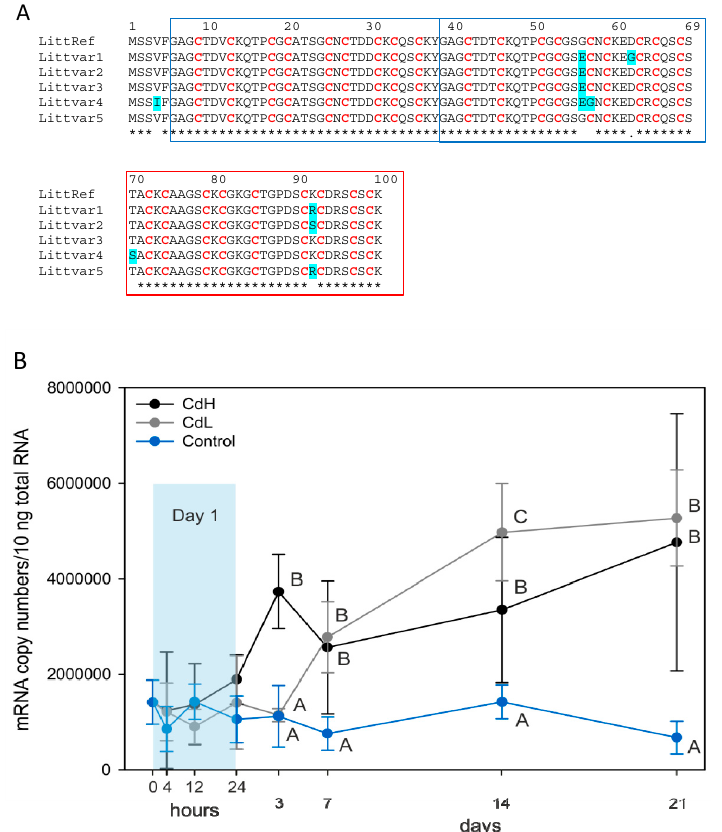
Figure 3. ( A ) Translated protein sequences of allelic variants of Littorina littorea , all of them caused by single nucleotide polymorphisms (SNPs) in the coding region of the respective gene. The sequence variants (Littvar1, Littvar2, Littvar3, Littvar4, Littvar5) are aligned with the first reported reference sequence (LittRef) of the Littorina littorea MT (GenBank Acc.Nr.: AY034179.1) [31]. Exchanged amino acid residues in the allelic variants are marked in blue. The tri-partite structure of the protein into different domains is indicated by blue ( α domains) and red frames ( β domain) [37]. The allelic variant sequences are available from GenBank under the acc. nrs.: KY963497 (Littvar 1), KY963498 (Littvar2), KY963499 (Littvar3), KY963500 (Littvar4) and KY963501 (Littvar5); ( B ) mRNA transcription of the Cd metallothionein (MT) gene of Littorina littorea in control animals (Control, blue line and symbols) and in winkles exposed to nominal Cd concentrations of 0.25 mg/L (CdL, grey line and symbols) and 1.00 mg/L (CdH, black line and symbols) over a period of 21 days. Mean values and standard deviations ( n = 4) are shown. The significance of the mRNA transcription curves was confirmed by ANOVA ( p ≤ 0.001). The significant differences of values between Cd-exposed and control individuals at different time points (Holm–Sidak pairwise multiple comparison, significance level 0.05) are indicated by different letters (A, B, C). Sampling points during the first 24 h (Day 1) are under-laid in blue.